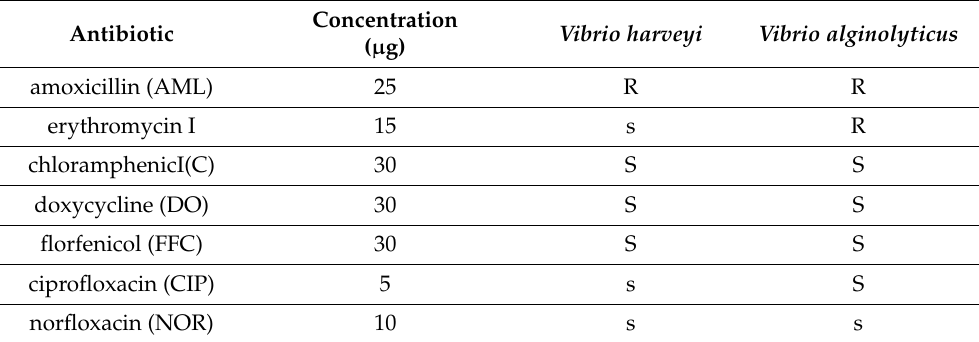
Table 2. Susceptibility of two pathogenic Vibrio strains to antibiotics through the results of the antibiogram tests.